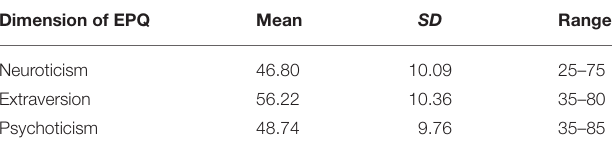
TABLE 2 | The descriptive statistics for the EPQ scores of all participants in the sample. Dimension of EPQ